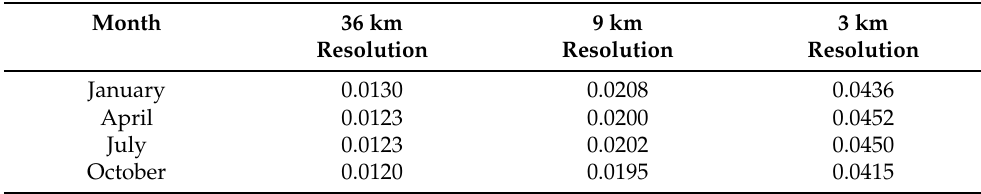
Table 1. RMS difference in cm 3 cm − 3 between soil moisture produced at several resolutions and with validated products. The 36 km column is the performance of this paper’s algorithm implementation compared to the reference data where the difference is due to algorithms.